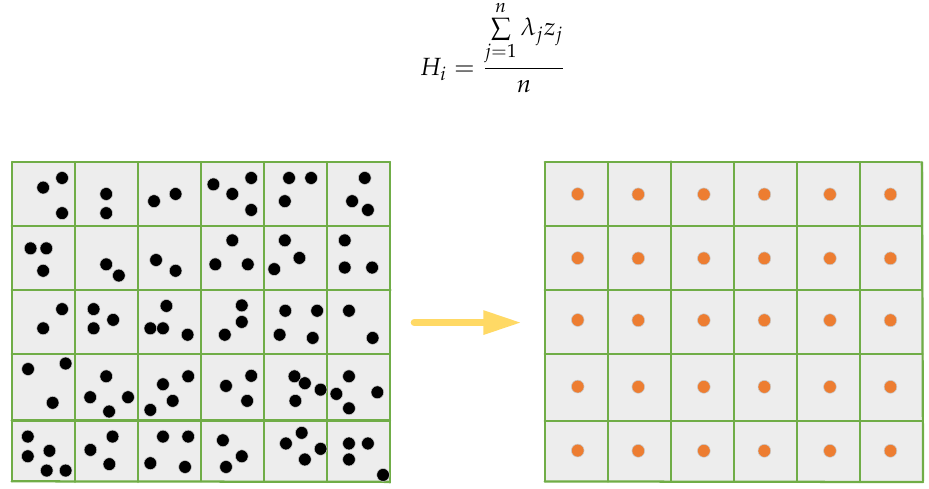
L X L Y Figure 6. Schematic diagram of meshing point cloud data. 4.1.4. Point Cloud Data Simplification